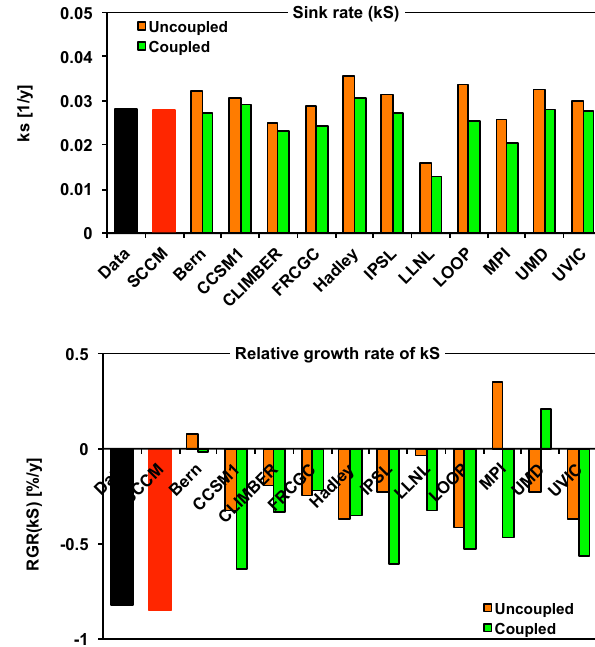
Figure 8. Upper panel: mean AF over 1959.0–2013.0 from data (black bars), SCCM (red bars) and 11 C4MIP models (Friedling- Figure 8 (source: C4MIP.EmissionsCO2.AFTrend+SinkRate.V04.xls) stein et al., 2006) in both uncoupled and coupled modes (orange and green bars, respectively). Lower panel: relative growth rate RGR(AF). For consistency of comparison, all trends are estimated using Eq. (A2) with annual data (the use of Eq. (A2) is necessary because many of the series change sign). This leads to small differ- ences between SCCM trend estimates in Figs. 8 and 3.